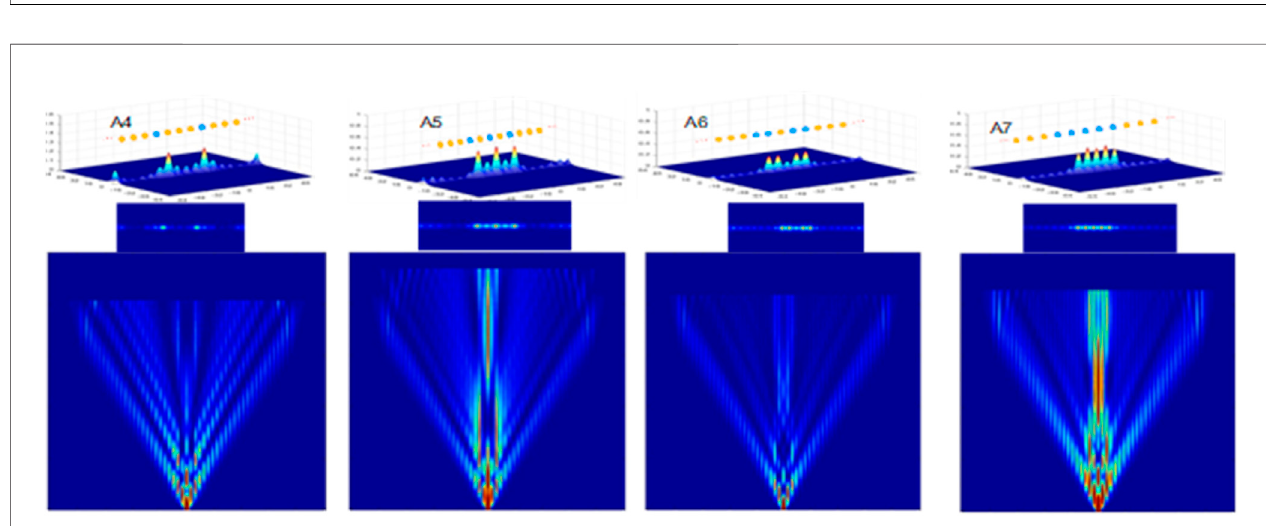
FIGURE 5 | Light propagations in BPLs A4 , A5 , A6 , and A7 similar to Figure 4 , but only show center of distributions which clearly resembles the structures of central cores of corresponding BPL s.